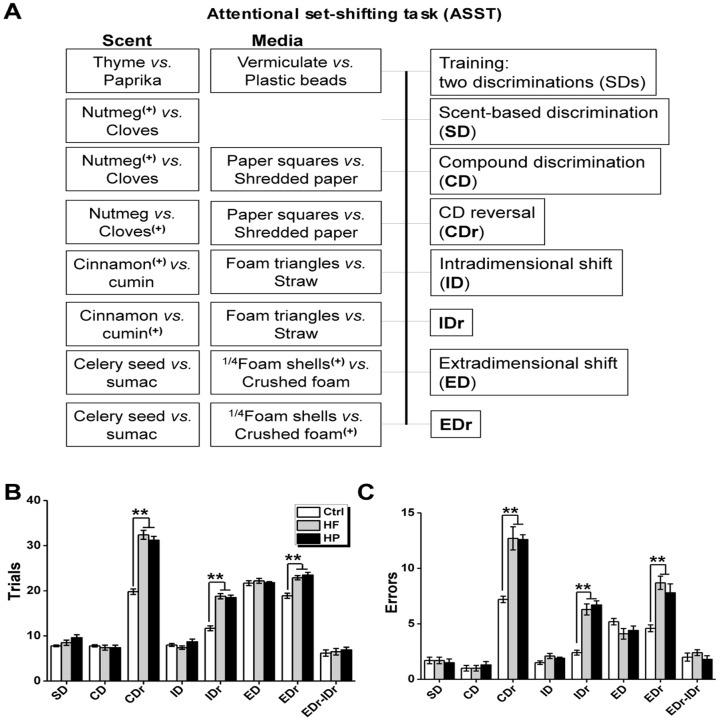
Reversal learning and set shifting in the ASST task.(A) Schematic representation of the behavioural training and testing protocol. The rewarded and unrewarded bowl is indicated with and without the “+”, respectively. The order of the discriminations and the exemplar pairings were always the same, but the pairs of exemplars were counterbalanced between groups. (B) Trials to reach criterion (six successive correct trials) for each phase of the ASST paradigm. (C) Errors made in each phase of the ASST paradigm. *p<0.05; **p<0.001.